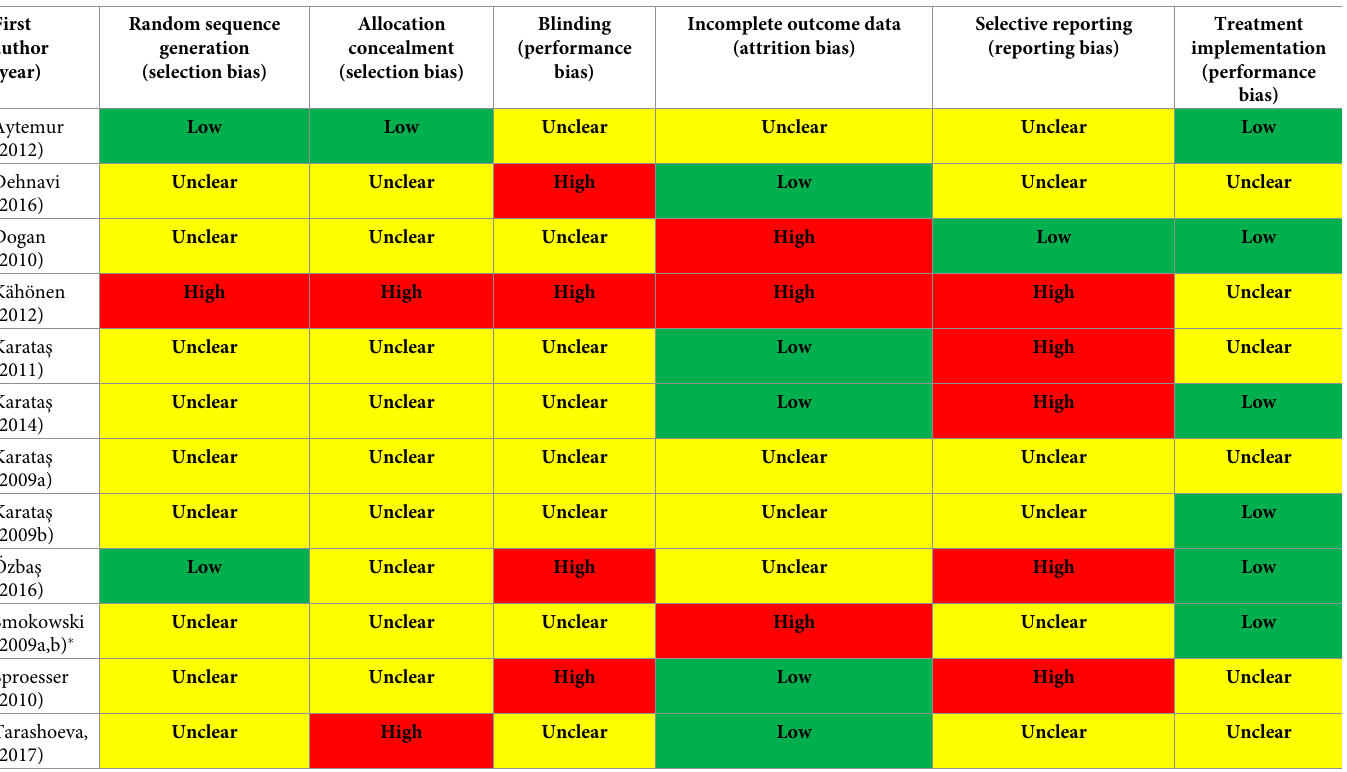
Table 5. Risk of bias assessment results per